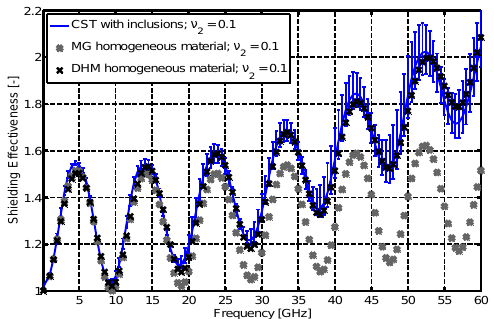
Figure 5: SE statistics from CST (cid:114) simulations (mean trend and extrema from 10 simulations, blue) in comparison to classical MG (bold gray crosses) formulation and proposed DHM (black crosses) with volumetric rate of inclusions ν 2 = 0 . 10 , and radius r = 0 . 050